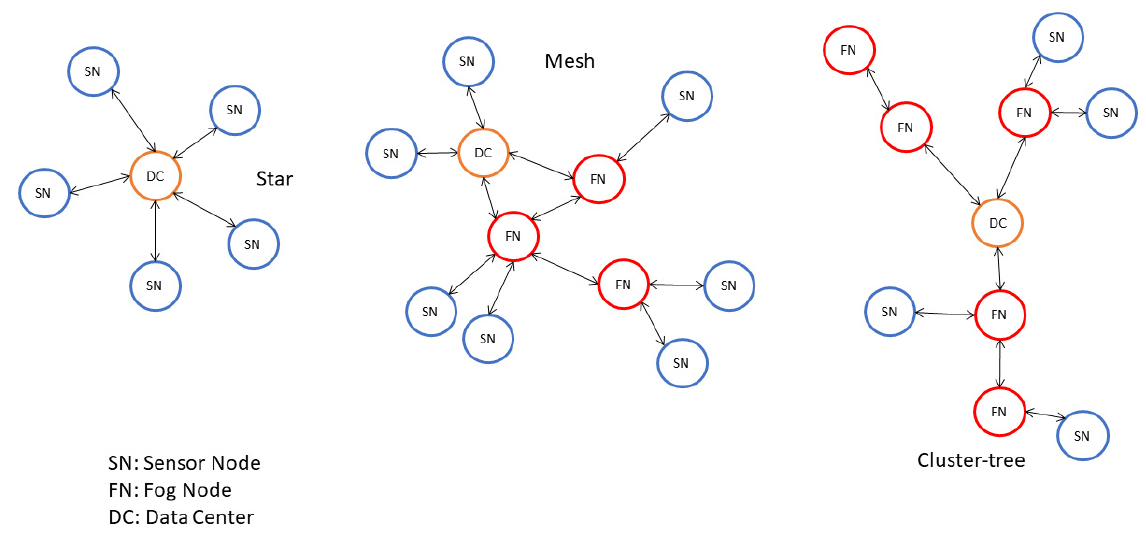
Figure 2. Star, mesh and cluster-tree architecture